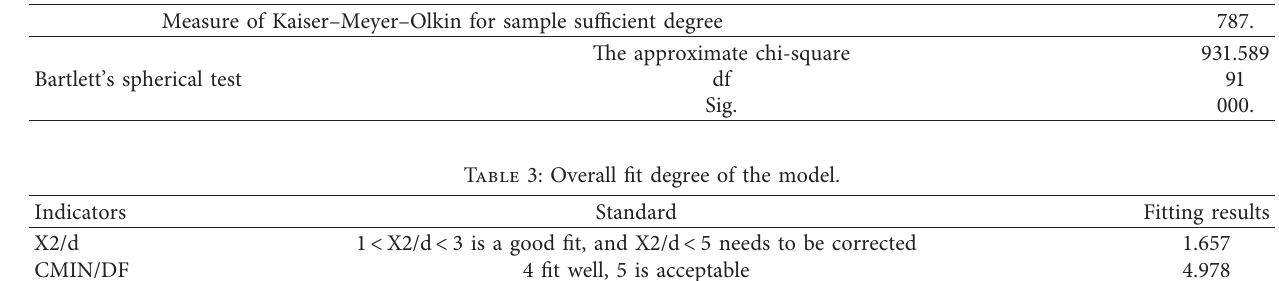
Table 2: KMO and Bartlett’s spherical test.